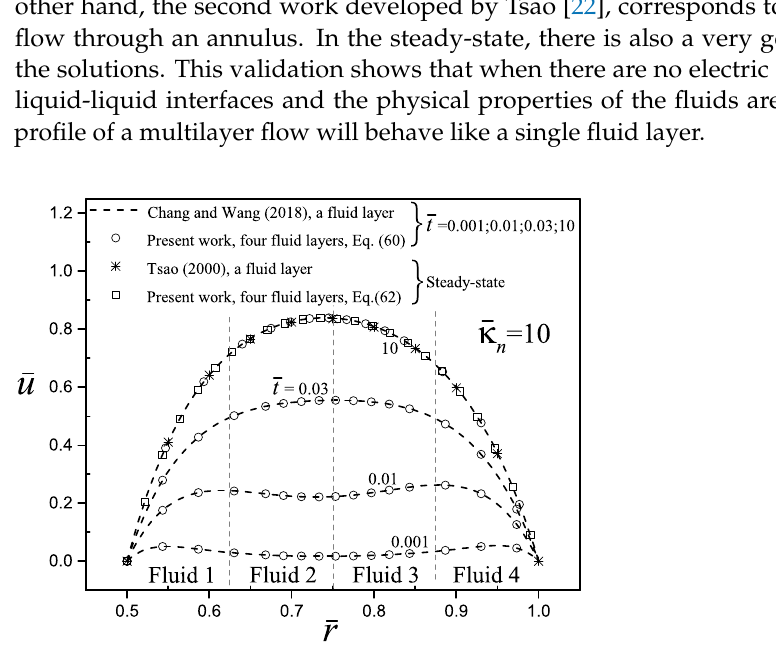
Figure 2. Comparison of the dimensionless velocity profiles in a purely electro-osmotic flow between the solutions presented by Chang and Wang [23] and Tsao [22] with n = 1, and the present work with n = 4, Γ = 0, ¯ η n = ¯ (cid:101) n = ¯ ρ n = ¯ ζ I,O = 1, ∆ ¯ ψ n = 0, ¯ r 1 = 0.625, ¯ r 2 = 0.75 and ¯ r 3 =